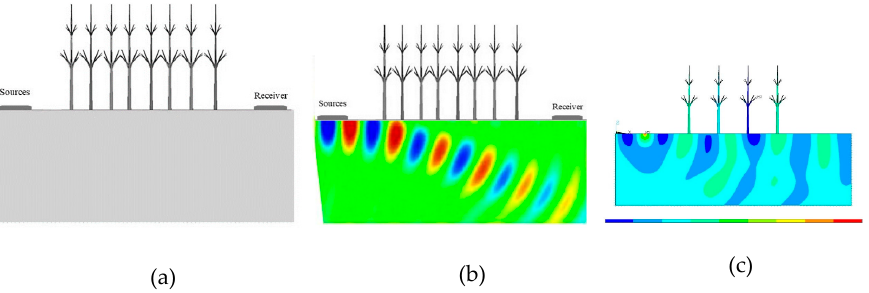
Figure 2. Two dimension of periodic trees: (a) NMs model; (b) 8 rows of NMs converting surface waves to bulk waves; and (c) 4 rows of NMs interacting with Rayleigh waves